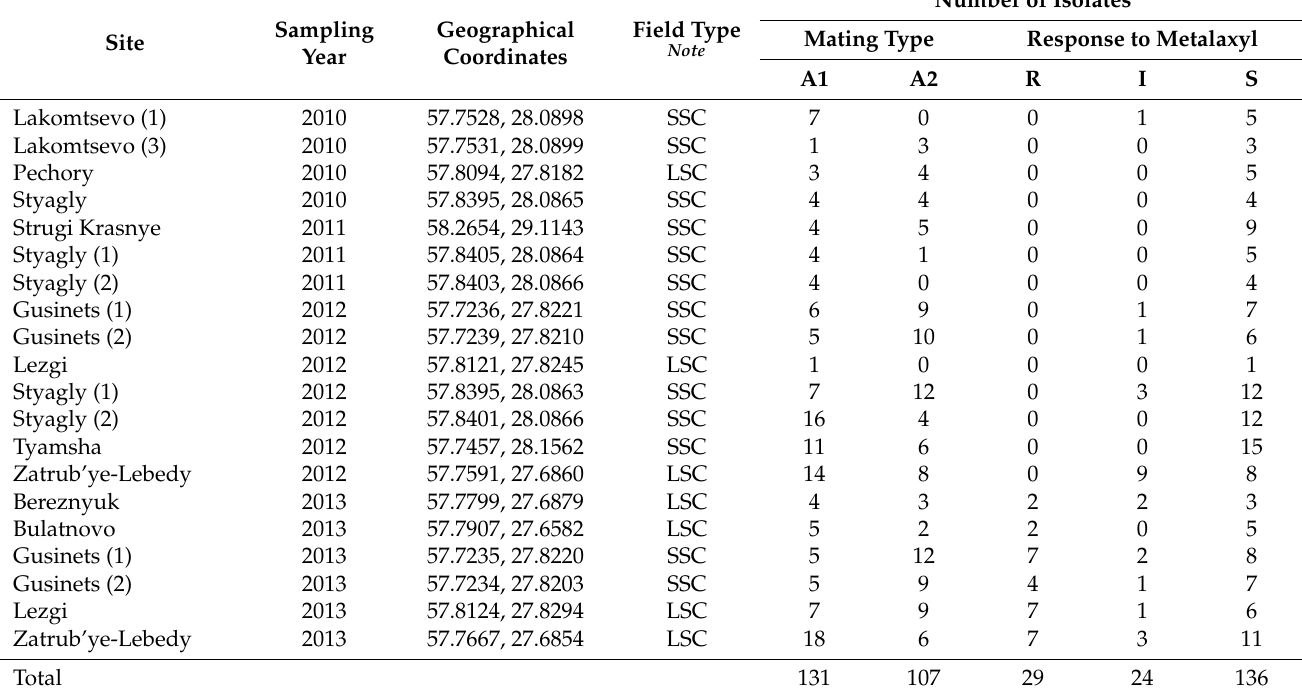
Table 1. The origin of Phytophthora infestans isolates collected in 2010–2013 from different sites in Pskov region, north-west Russia, and results of mating type (A1 and A2) and metalaxyl resistance (R—resistant; I—intermediate; S—sensitive)